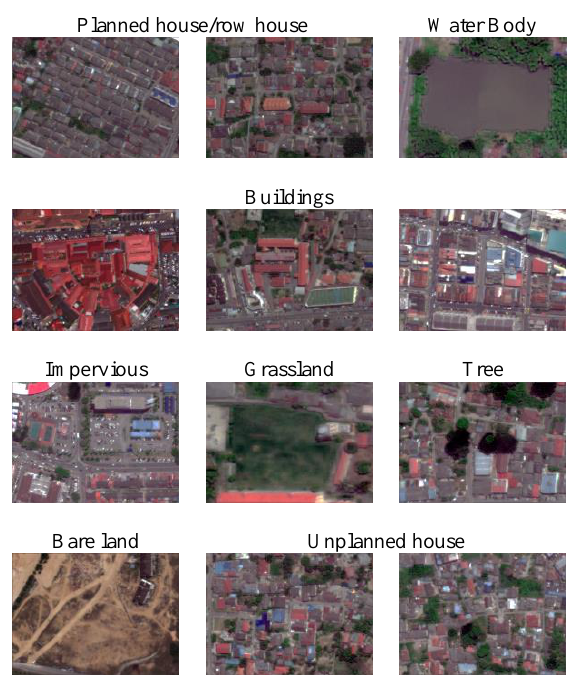
Figure 4. The urban structure type at study area